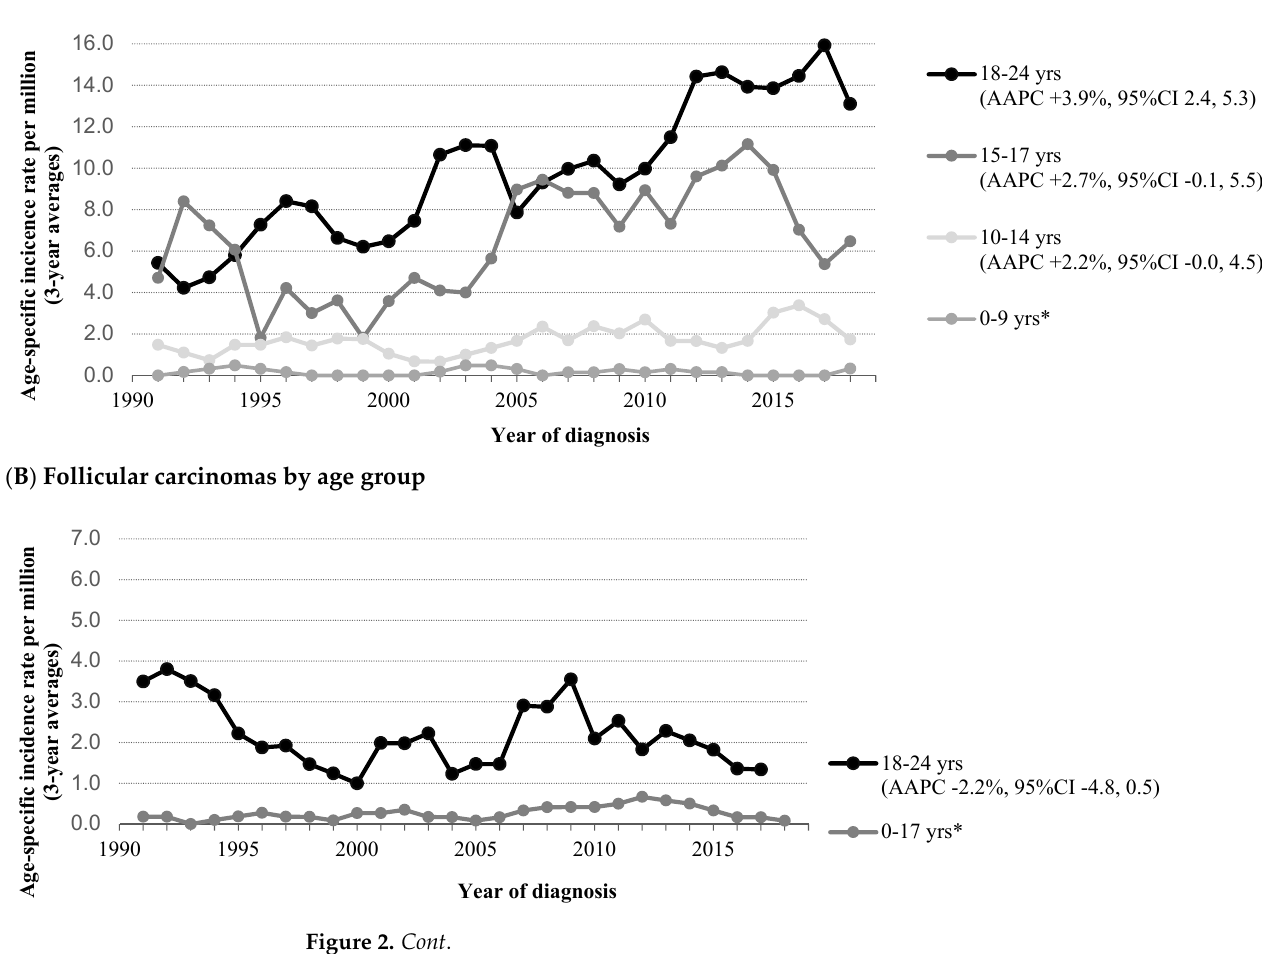
Figure 1. Time trends in incidence of patients aged 0–24 years with thyroid carcinoma in the Netherlands, 1990–2019. Abbreviations: AAPC, Average Annual Percent Change; CI, Confidence Interval. Three-year moving averages of the age-standardized incidence rate of thyroid carcinoma (standardized according to the World Standard Population) are shown. AAPC was estimated from a regression line, which was fitted to the natural logarithm of the rates using the year of diagnosis as a regressor variable.